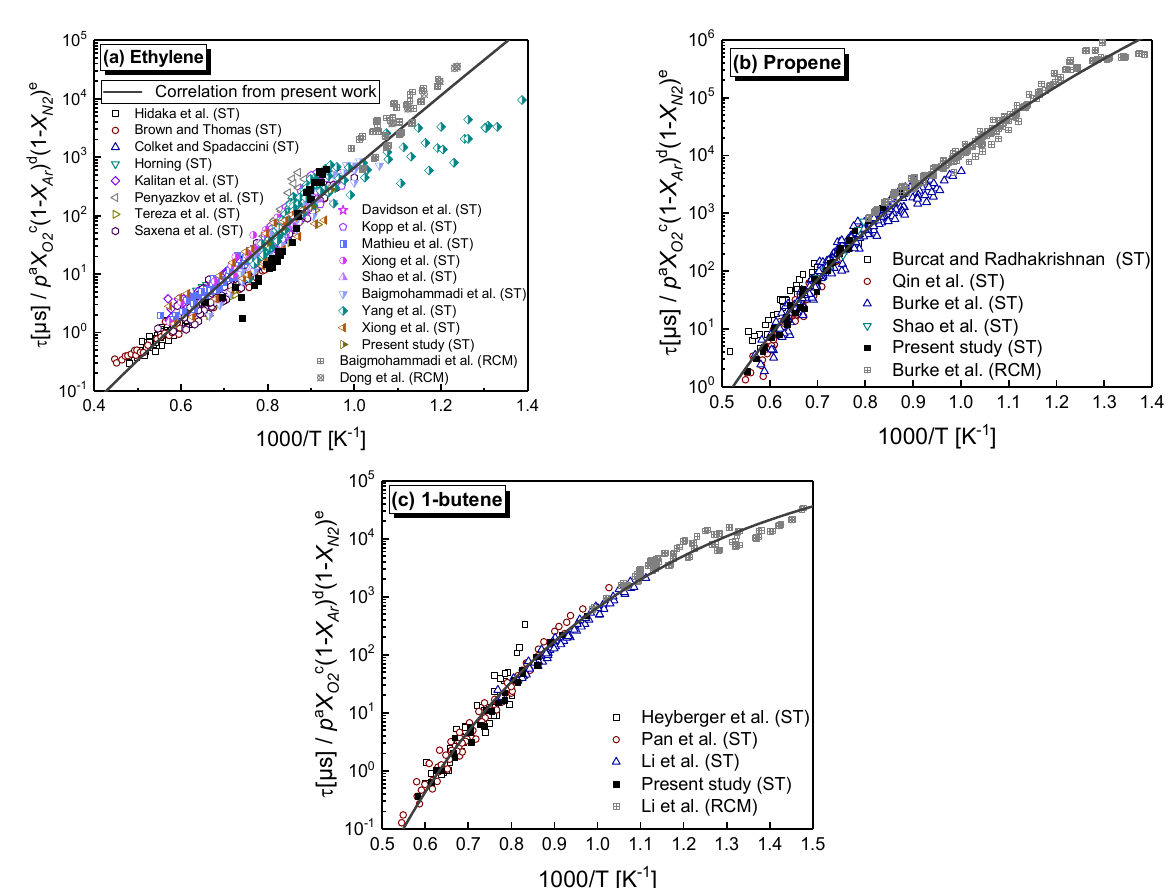
Figure 16. Arrhenius-type correlations of IDTs for ethylene ( a ), propene ( b ) and 1-butene ( c ). Symbols: experimental data from literatures (Hidaka et al. [13], Brown and Tomas [14], Colket and Spadaccini [16], Horning [15], Kalitan et al. [17], Penyazkov et al. [19], Tereza et al. [20], Saxena et al. [21], Davidson et al. [22], Kopp et al. [23,24], Mathieu et al. [25], Xiong et al. [26], Shao et al. [27], Baigmohammadi et al. [28], Yang et al. [32], Xiong et al. [31], Dong et al. [29], Burcat and Radhakrishnan [34], Qin et al. [35], Burke et al. [38,39], Heyberger et al. [36], Pan et al. [42], Li et al. [43]) and present study, lines: correlation predictions.